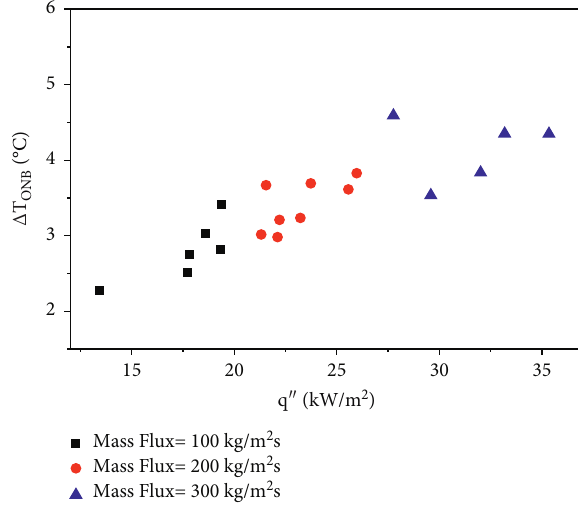
Figure 13: Effect of mass flux on Δ T